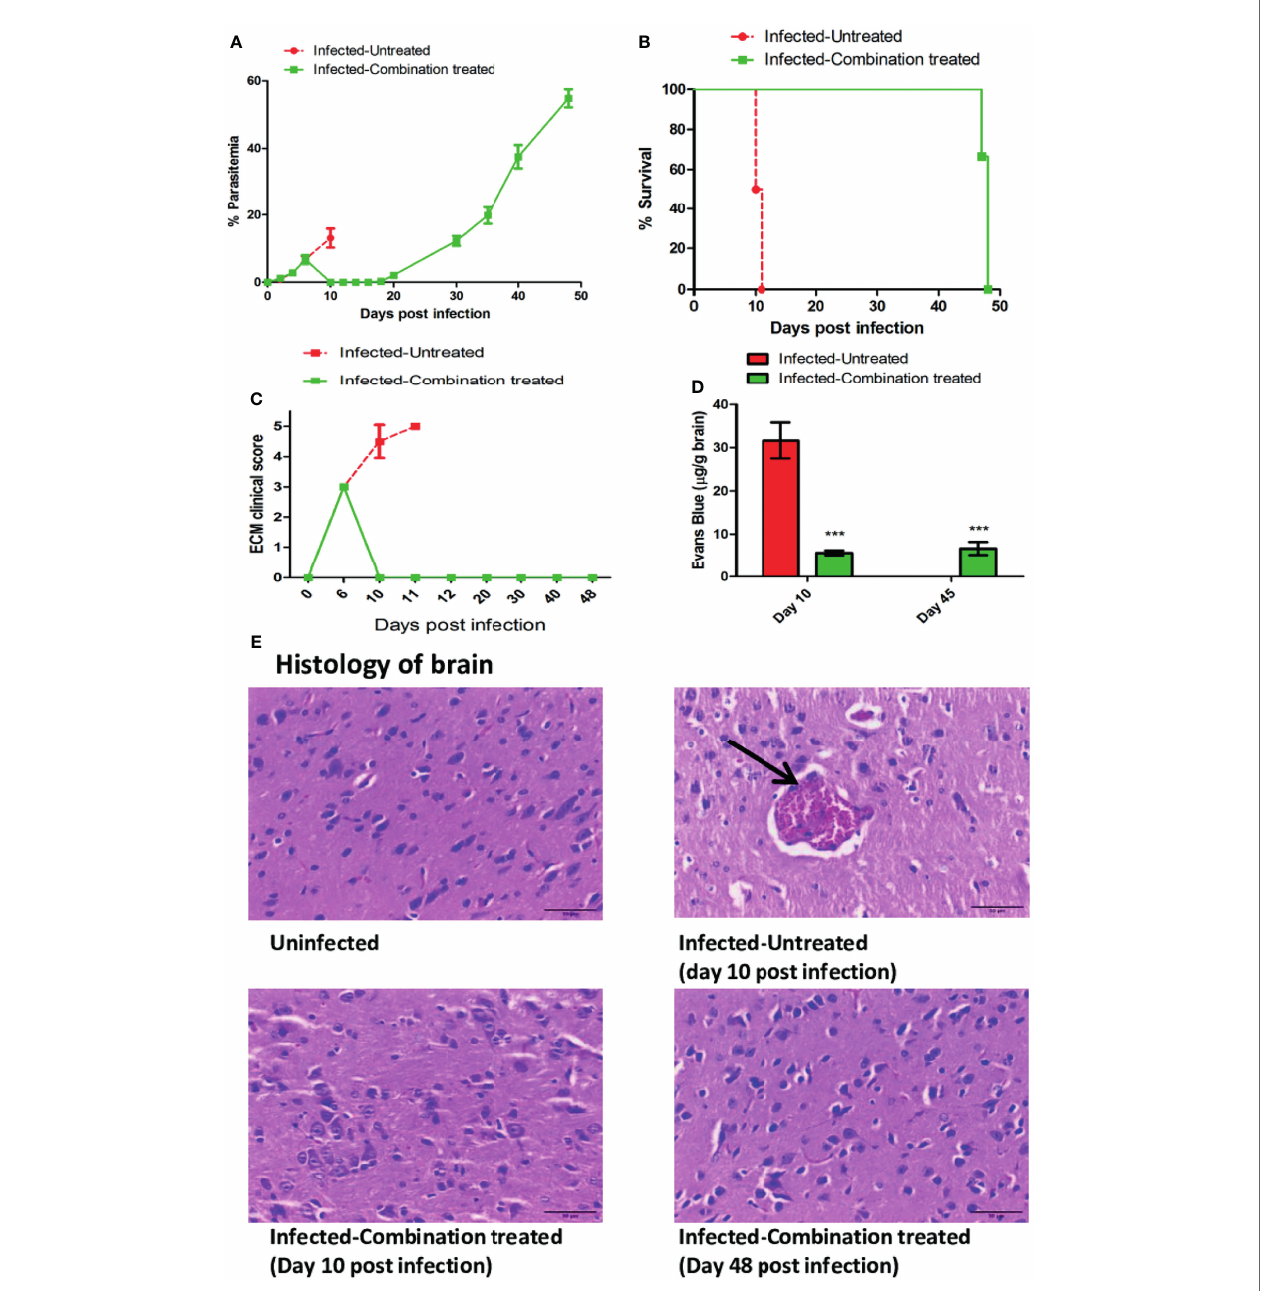
FIGURE 4 | Ef fi cacy of treatment with a combination of ART+AC9+AND+CUR in P. berghei ANKA infected C57BL/6 was evaluated. Infected-untreated mice were treated with only PBS. (A) Trend in parasitemia, (B) Survival curve, (C) ECM clinical score and (D) Quantitation of Evan ’ s Blue dye extravasation in the brain of infected-untreated vs infected-combination treated group was evaluated. Parasitemia, survival curve and ECM clinical score data is representative of 3 independent experiments and data from 6 mice per group has been represented. Evan ’ s Blue Dye quantitation data is expressed as mean ± SD from 3 mice per group. [* P <0.05, ** P <0.01, *** P <0.001, n.s., not signi fi cant]. (E) Histology of cortical sections of brain from uninfected, infected-untreated and infected-combination treated groups. Black arrow indicates the sequestration of infected erythrocytes in the brain microvasculature. Scale bar: 30 m